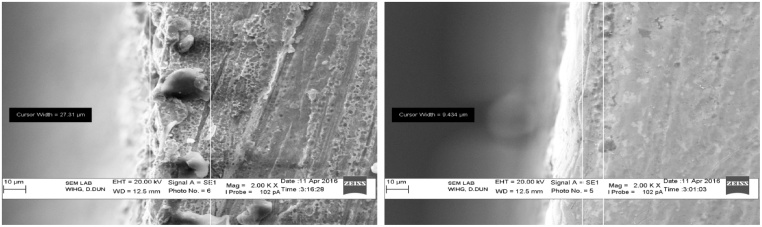
(a) Recast layer thickness for trial 1 (b) Recast layer thickness for the trial 7th.